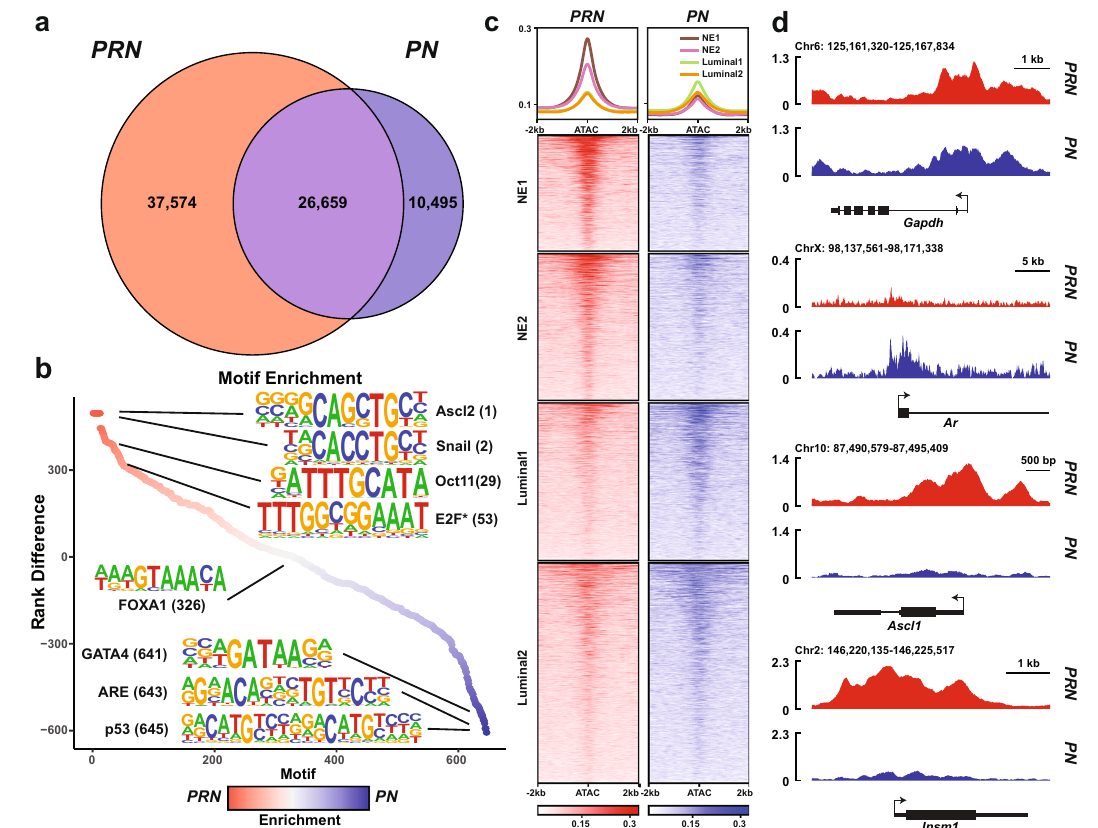
Fig. 6 The N-Myc cistrome is altered upon Rb1 loss. a Venn diagram showing the overlap of N-Myc binding by ChIP-seq from PRN ( n = 3) and PN ( n = 2) tumors (peak cutoff: q < 0.0001). b Differential transcription factor motif enrichment between N-Myc binding sites in PRN and PN tumors. c Heatmaps of N-Myc binding in PRN and PN tumors at regions of accessible chromatin associated with neuroendocrine and luminal subpopulations by scATAC-seq in Fig. 5a. d N-Myc binding at indicated loci in PRN ( n = 3) and PN ( n = 2)